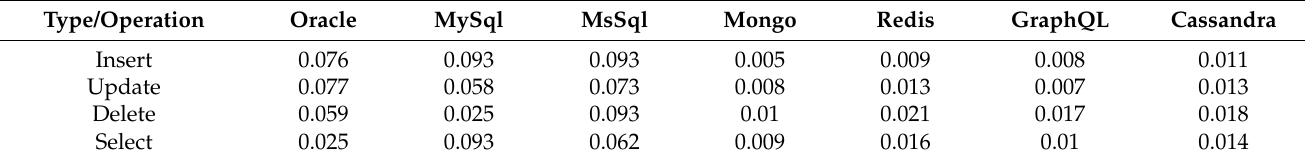
Table 3. Query performance of databases with 10,000 records in milliseconds.